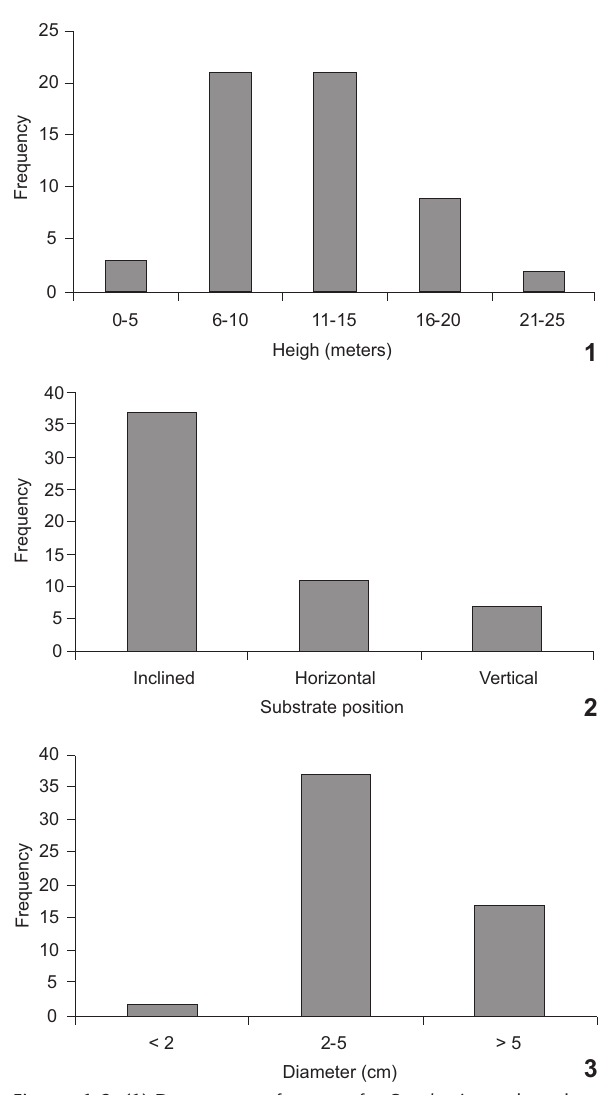
Figures 1-3. (1) Day roost preference of a C. subspinosus based on 15 roosts vertical stratification in Santa Lúcia Biological Station, southeastern Brazil; (2) substrate position of roosts used by a C. subspinosus ; (3) diameter classes of braches used by C. subspinosus as resting